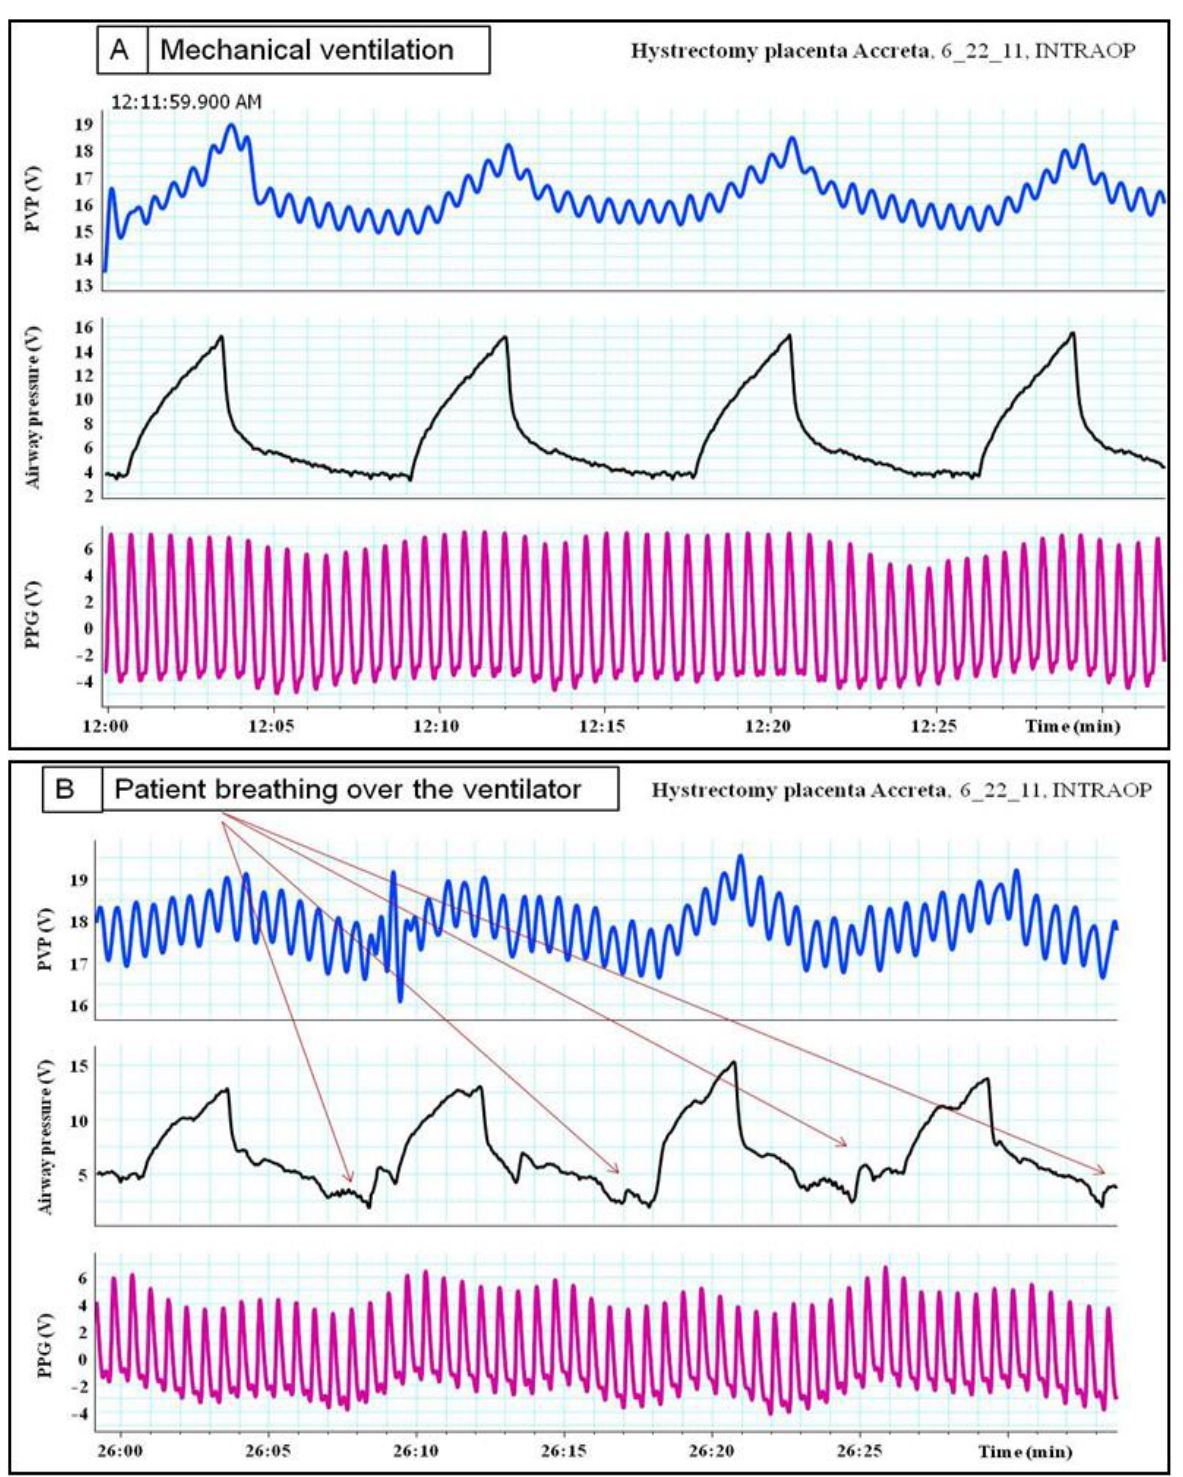
Figure 11. ( A ) Volume controlled mechanical ventilation. ( B ) The same patient when she started to breath over the ventilator. Notice the modulation of plethysmographic waveforms and changes in the pattern of peripheral venous pressure (PVP)